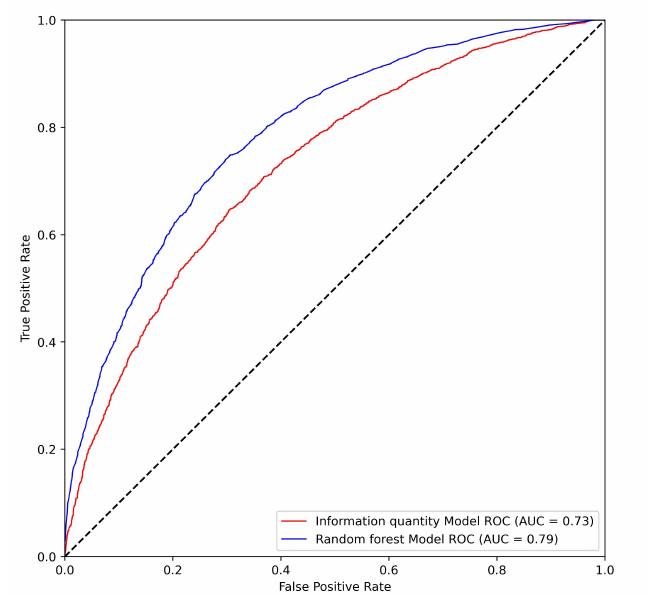
Figure 4. Comparison of ROC values between the random forest model and information quan- tity model.